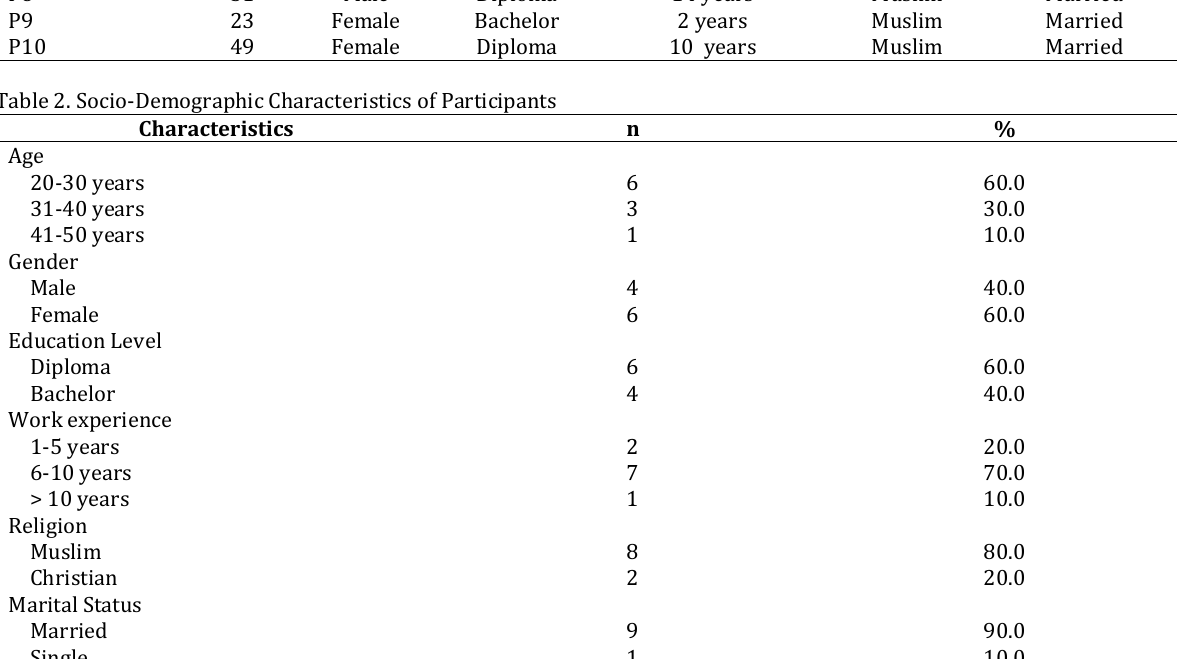
Table 2. Socio-Demographic Characteristics of Participants